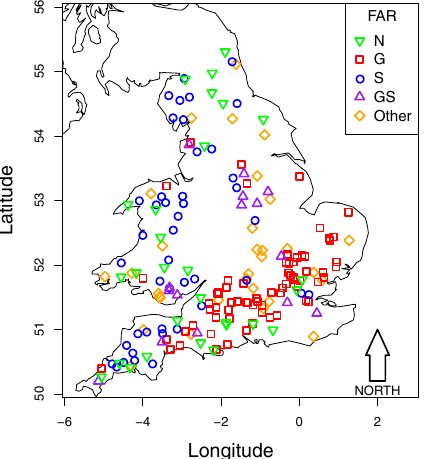
Figure 1. Gauging station locations and Factor Affecting Runoff (FAR) codes for corresponding